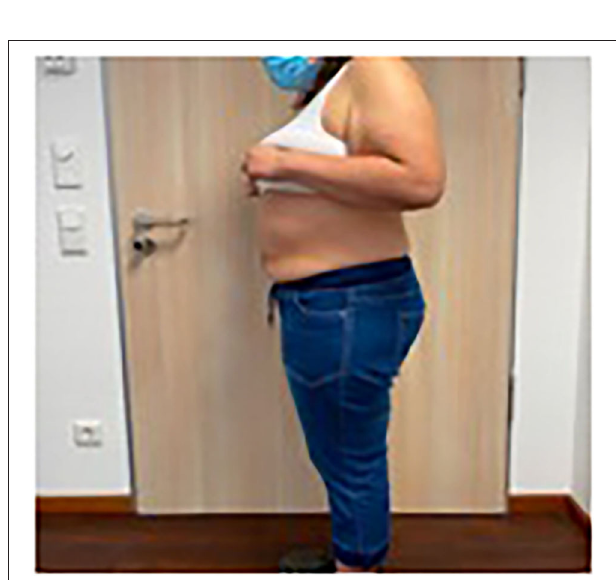
FIGURE 5 | Patient 1 follow-up, private archive Dr. M. Renter